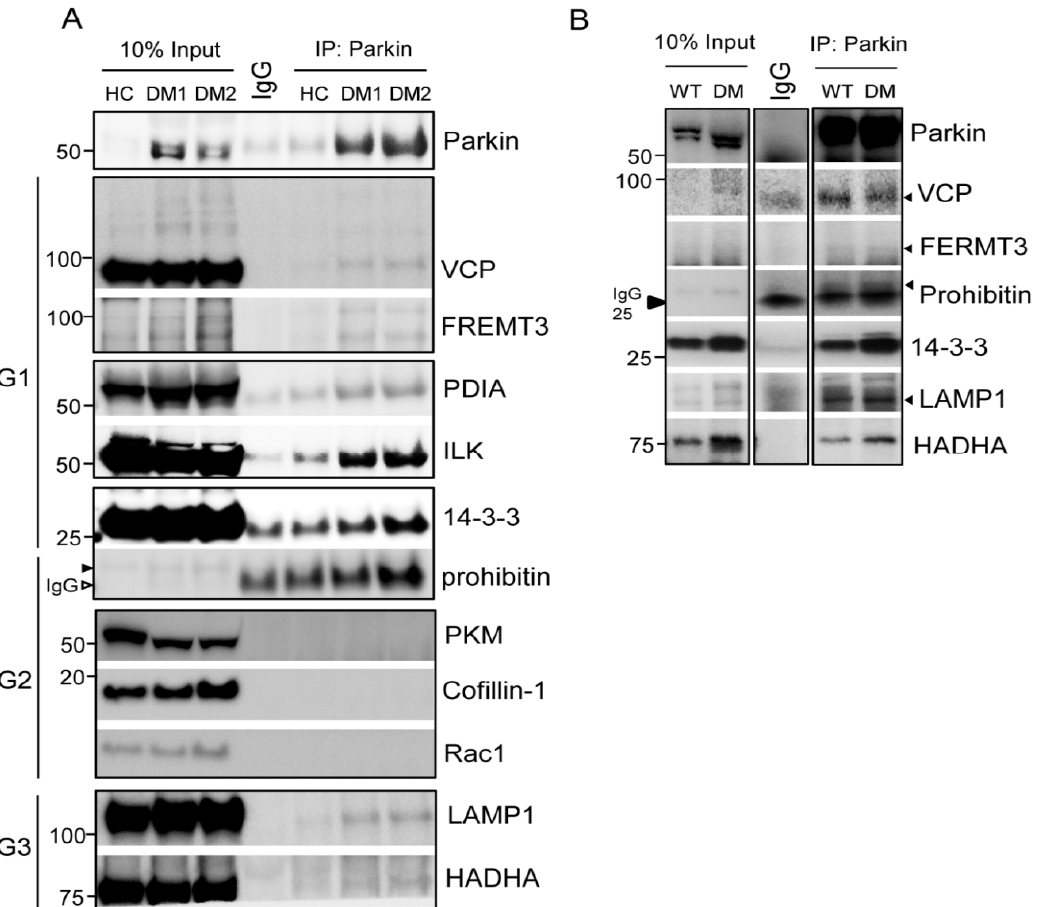
Figure 3. Confirmation of interactions between Parkin and selected target proteins in human and murine platelets. ( A ) Immunoprecipitation of each specific antibody in pooled human DM platelets (4 HC, 5DM1, and 6DM2). We incubated 500 μ g protein lysates incubated with specific antibodies overnight at 4 °C with 10% input as control. G1 represents interacting protein groups from LC ‐ MS/MS results. G2 represents the non ‐ interacting proteins group in LC ‐ MS/MS results. G3 represents protein that interacted with Parkin and that were not found in the LC ‐ MS/MS results. ( B ) Immunoprecipitation of each specific antibody in pooled murine platelets (3 WT and 5DM). We incubated 500 μ g protein lysates incubated with specific antibodies overnight at 4 °C with 10% input as control.